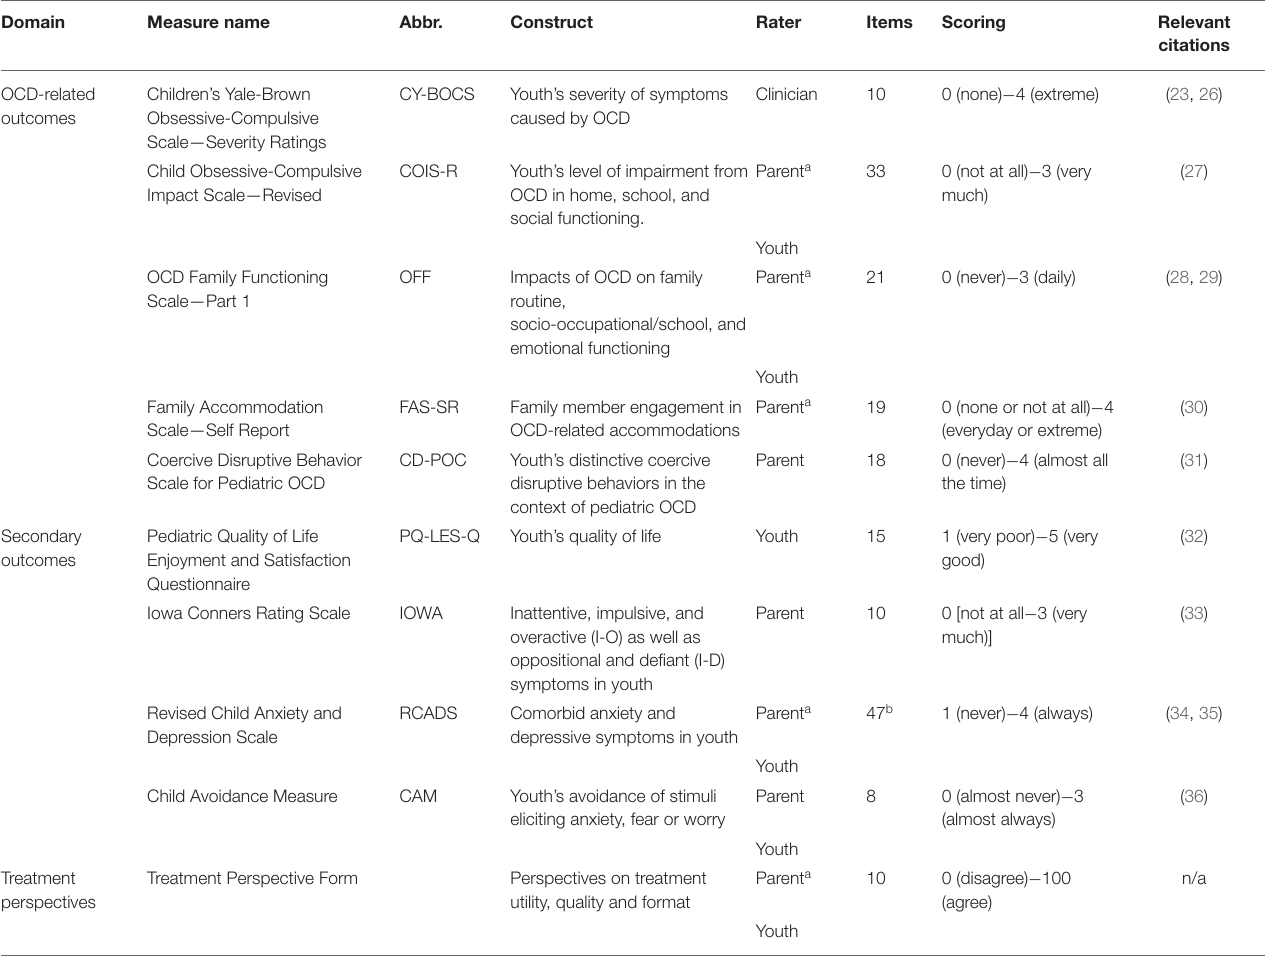
TABLE 1 | Outcomes measures included in the present study.